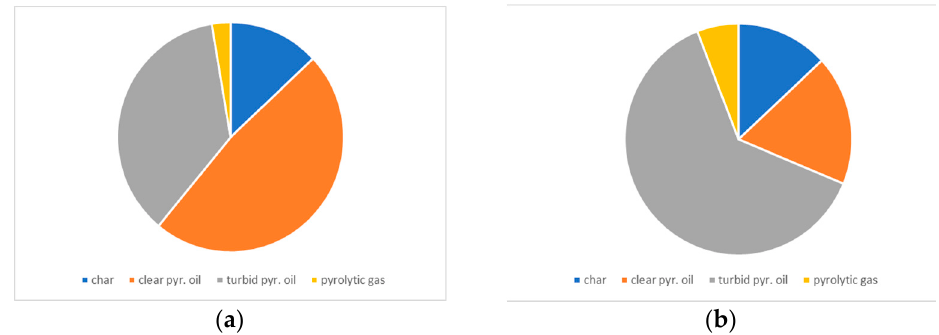
Figure 2. Migration of sulfur in pyrolysis products: ( a ) for contaminated foils; ( b ) for mixed plastics.